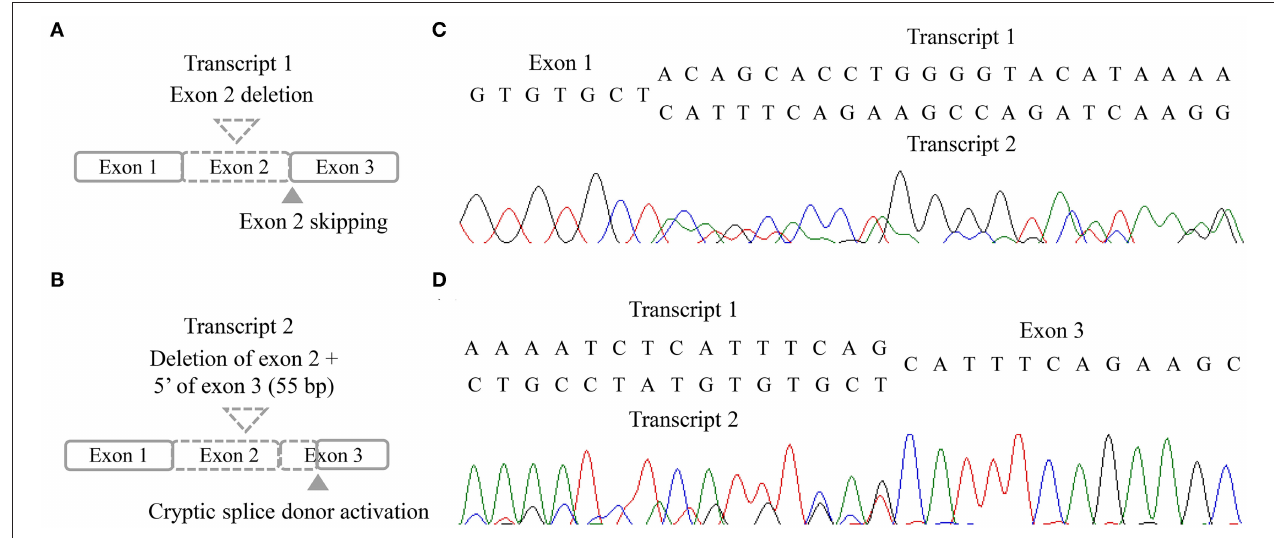
FIGURE 3 | RNA results of the patient. (A,B) Schematic illustration of two aberrant transcripts. (C,D) Sequencing chromatogram in forward direction (C) and reverse direction (D)